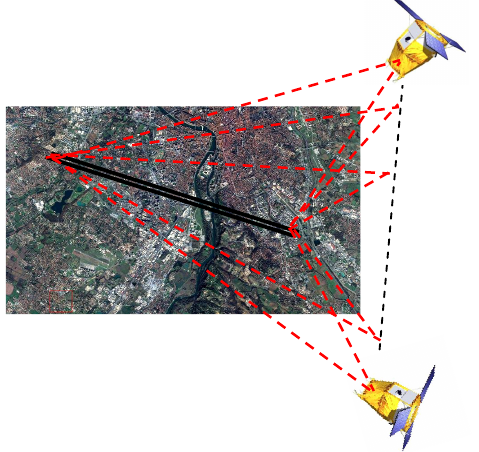
Figure 11: « Steady-mode » acquisition principle